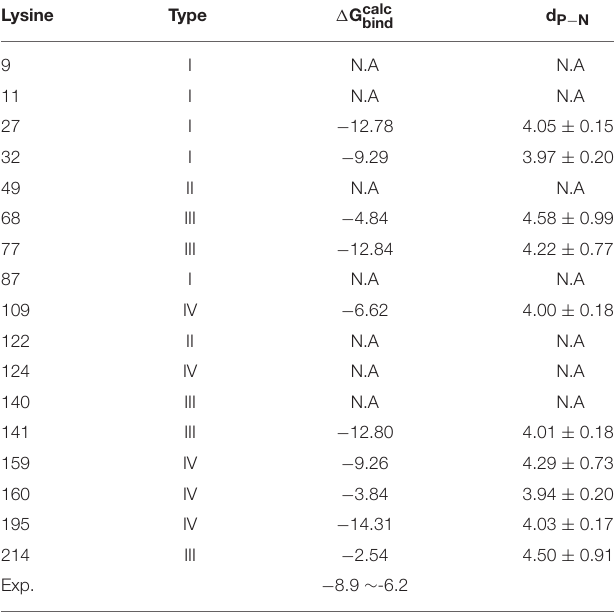
TABLE 2 | Binding free energies for tweezer/K complexes and the ion pair